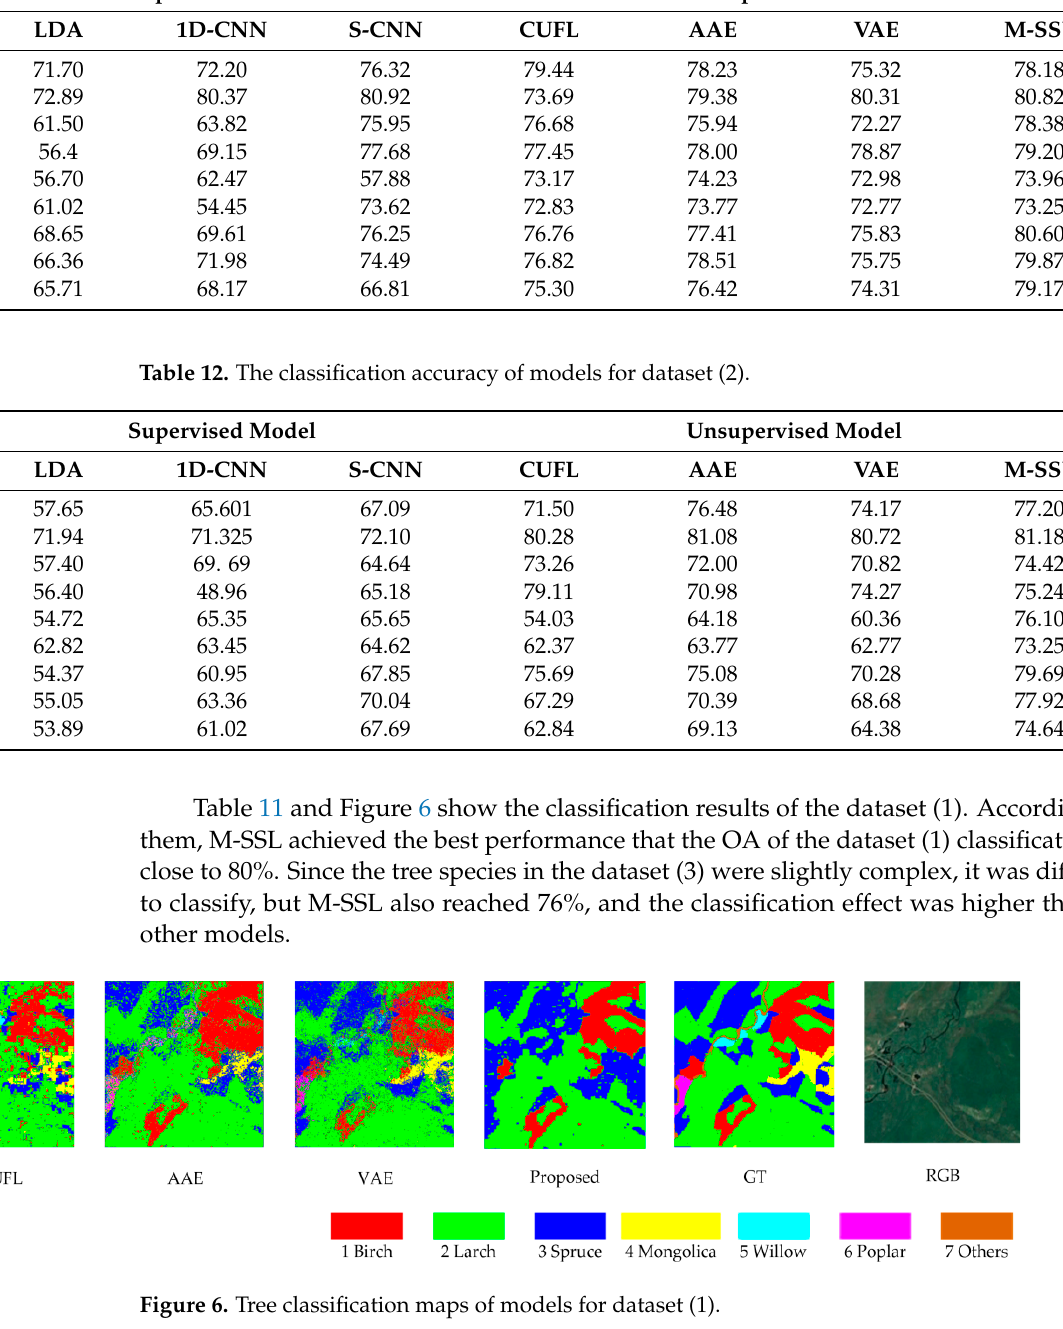
73.65 Figure 7. Tree classification maps of models for dataset (2).